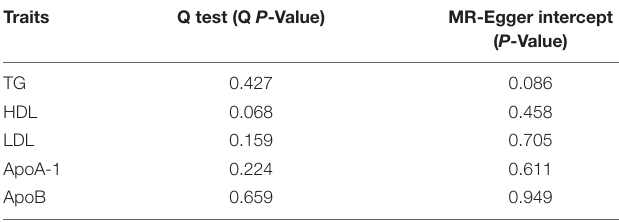
TABLE 3 | The estimates of Q test and MR-Egger intercept. Traits